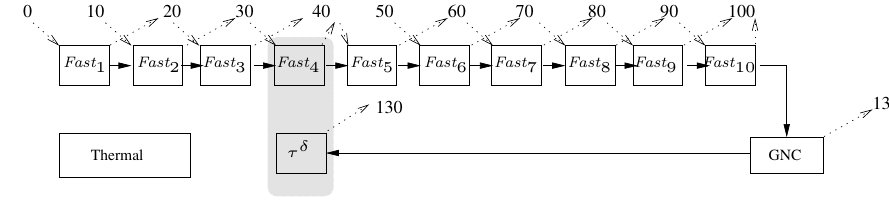
Figure 9 Delay removal result for the example in Figure